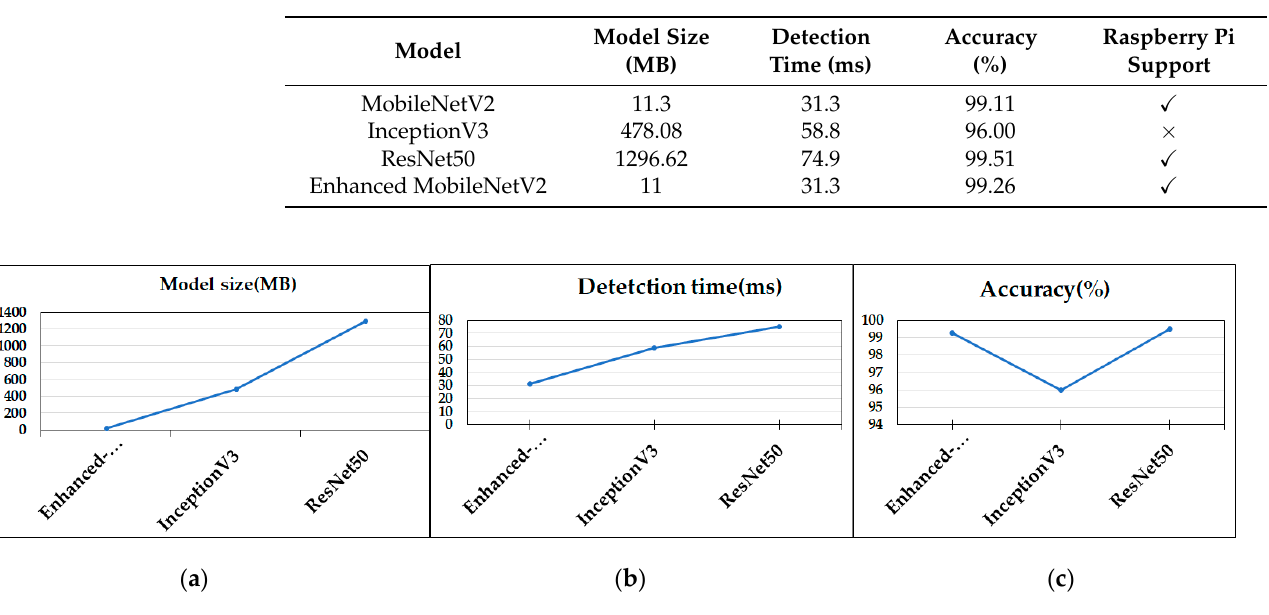
Figure 9. A comparison of the proposed model (enhanced MobileNetV2) with InceptionV3 and ResNet50 in terms of ( a ) size; ( b ) detection time; and ( c ) accuracy when evaluating the RMFD dataset. Table 2. Training and validation of the enhanced MobileNetV2 model on Adam.